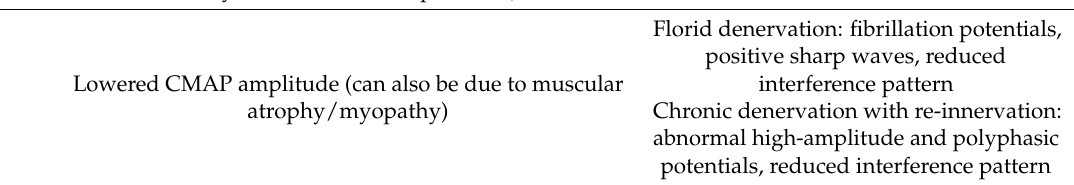
Table 2. Electrophysiological criteria for demyelinating or axonal damage to peripheral nerves. Motor Neurography EMG Slowing of NCV, prolongation of distal-motor latency, prolongated or deficient F-waves (in proximal Demyelination demyelination), abnormal dispersion of CMAP and partial conduction block (acquired multifocal demyelination, for example CIDP) Lowered CMAP amplitude (can also be due to muscular Axonal damage atrophy/myopathy)